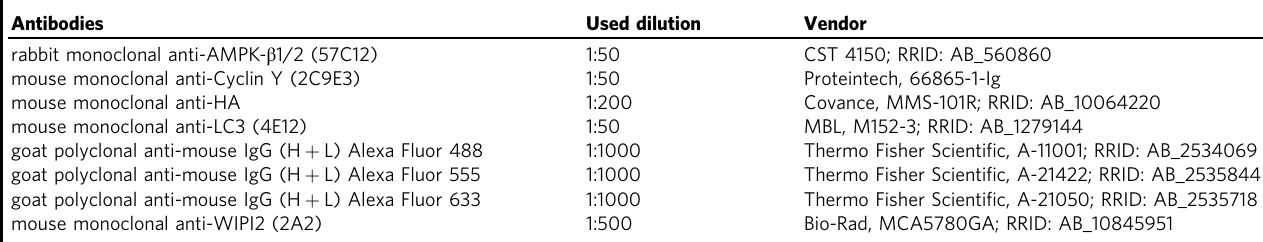
Table 2 Antibodies used for immuno fl uorescence staining. Antibodies Used dilution Vendor rabbit monoclonal anti-AMPK- β 1/2